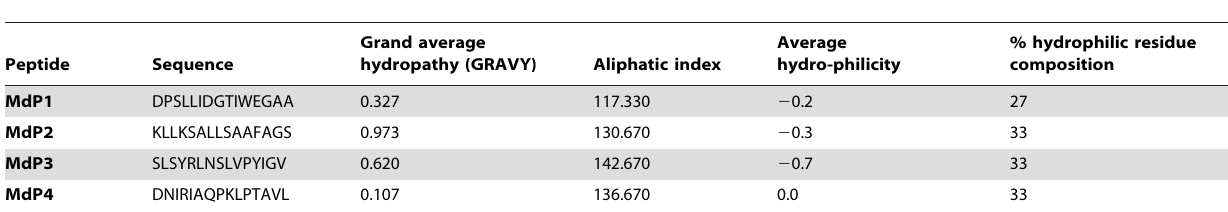
Table 1. Analysis of the physico-chemical properties of four novel MOMP-derived peptides.